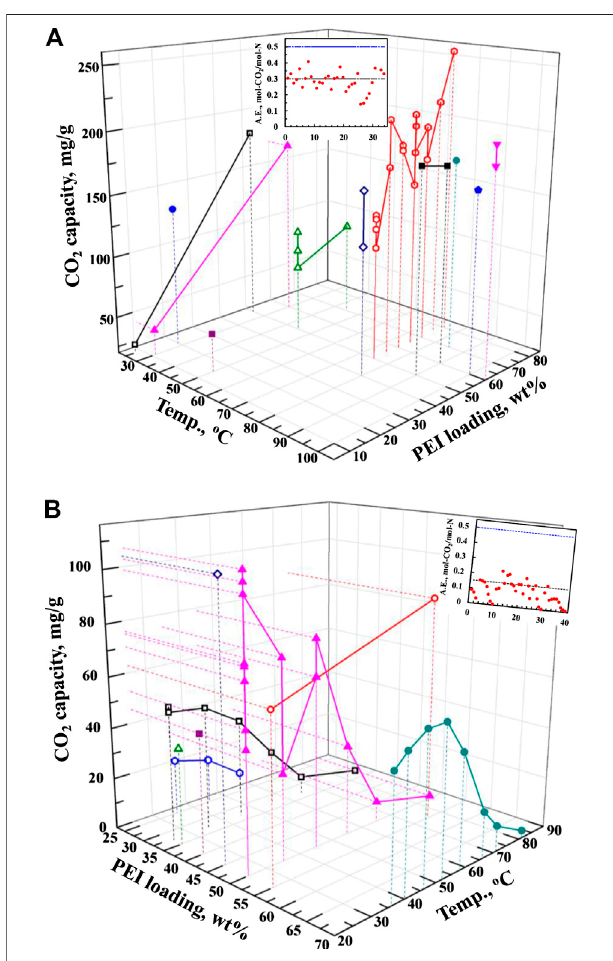
FIGURE 7 | CO 2 capacity reported in the literature with different support at different PEI loading and temperature for CO 2 capture from (A) pure CO 2 and (B) from simulated air with about 400 ppm CO 2 along with the insets showing the amine ef fi ciency (A.E., mol-CO 2 /mol-N). All data are from the reported values (Wang and Song,